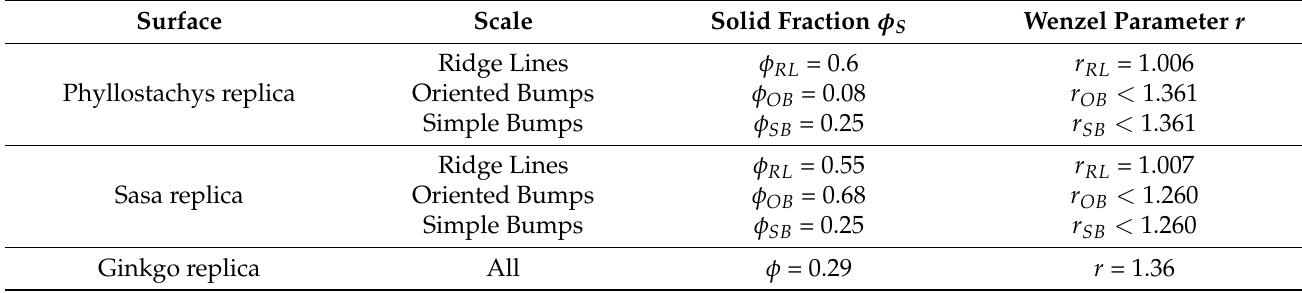
Table 3. Solid fraction and Wenzel parameter of each scales of